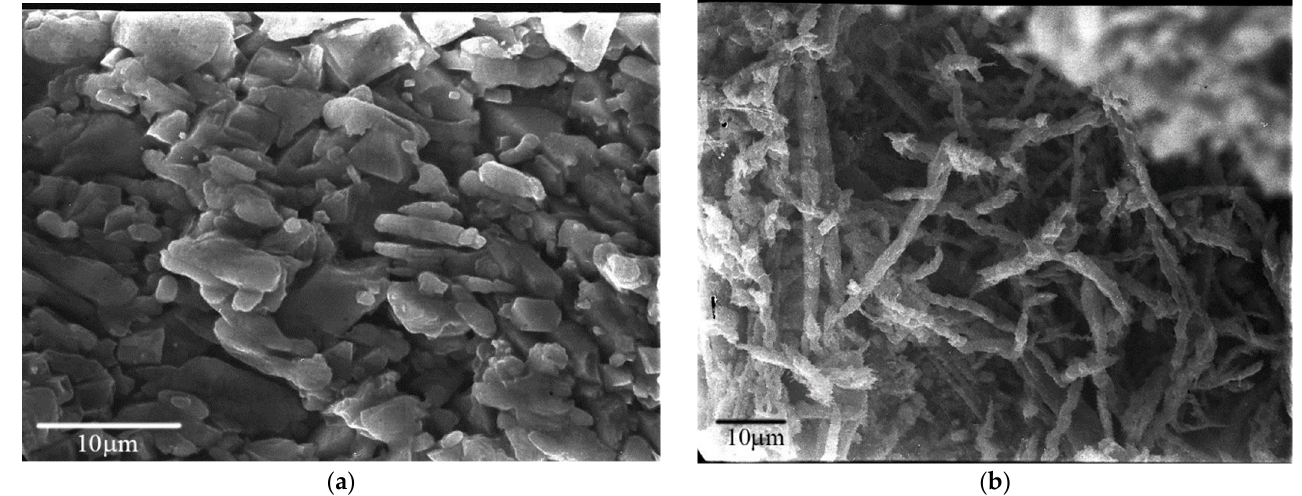
Figure 5. SEM images of polycarbazole prepared in the absence ( a ) and presence of an electrical field ( b ).